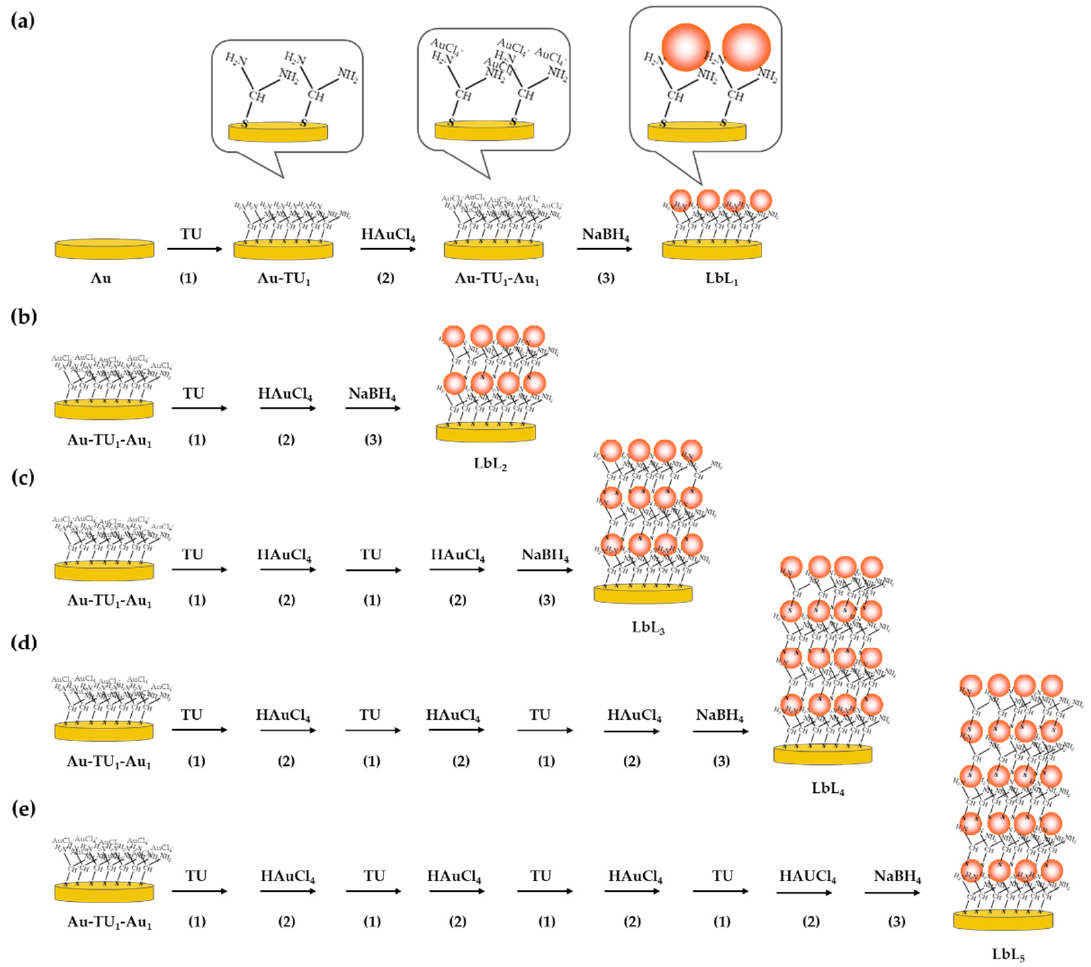
Figure 1. Preparation of layer-by-layer self-assembly of TU and HAuCl 4 on the electrode surface ( a ) preparation of 1 layer and ( b – e ) preparation of 2, 3, 4, and 5 layers, respectively.